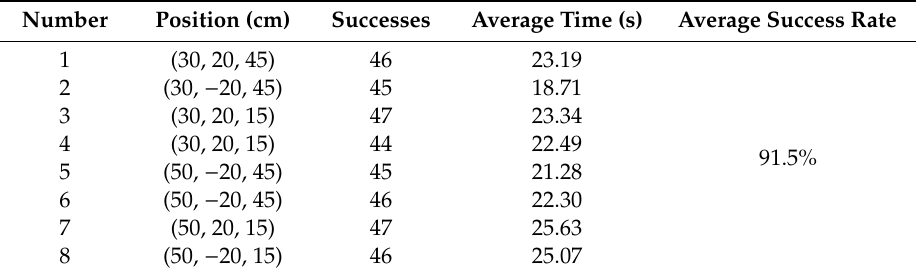
Table 4. Experimental data.